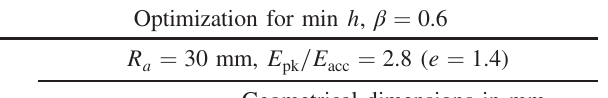
=E = 42 , and dimensions of TABLE VI. Values of h ¼ H pk acc optimized inner cell (two elliptic arcs and a straight segment) vs =E the slope angle α . Optimization for min H (or min h ). pk acc Optimization for min h , β ¼ 0 .